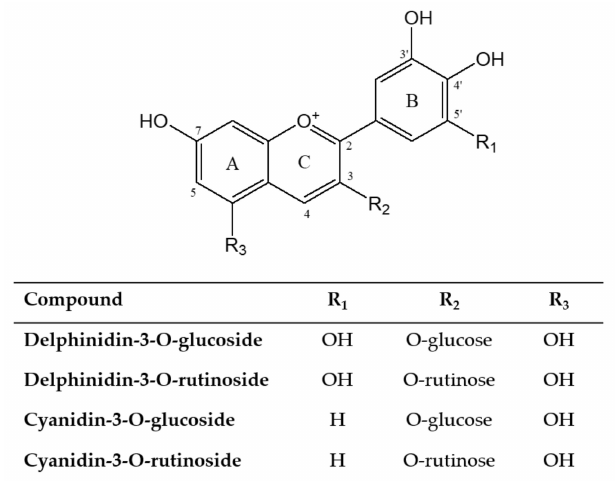
Figure 3. Chemical structures of anthocyanins sourced from